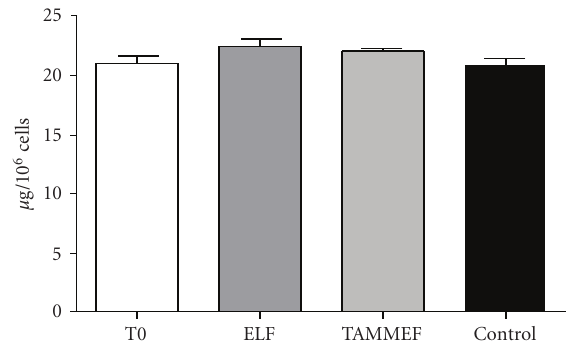
Figure 3: Total protein content ( μ g/10 6 PBMCs; mean ± SD of five independent experiments) of T0 cells, control cells, and cells treated with ELF EMFs and